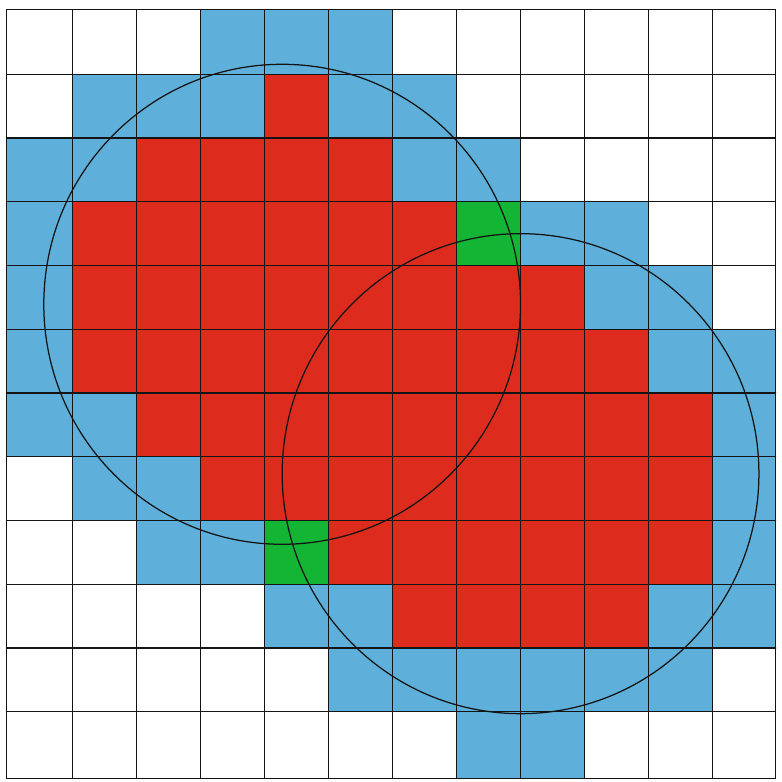
Figure 5: The relationship between the cells and the constellation coverage region. Table 1: The result of m ½ G